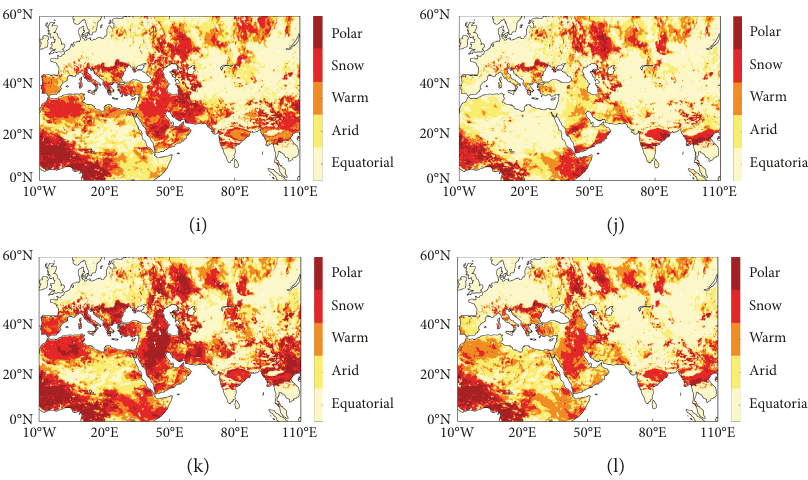
Figure 4: Spatiotemporal distribution of drought in Belt and Road area. (a) Jan. 1998. (b) Feb. 1998. (c) Mar. 1998. (d) Apr. 1998. (e) May. 1998. (f) Jun. 1998. (g) Jul. 1998. (h) Aug. 1998. (i) Sept. 1998. (j) Oct. 1998. (k) Nov. 1998. (l) Dec. 1998.